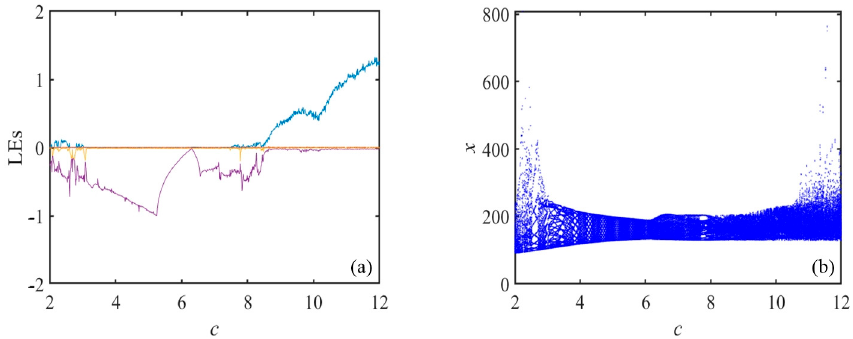
Figure 4. ( a ) Lyapunov exponent spectrum; ( b ) bifurcation diagram.